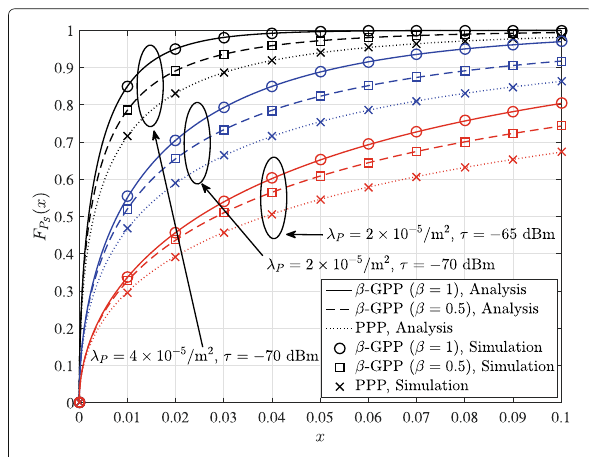
Fig. 3 CDF of transmit powers at SUs